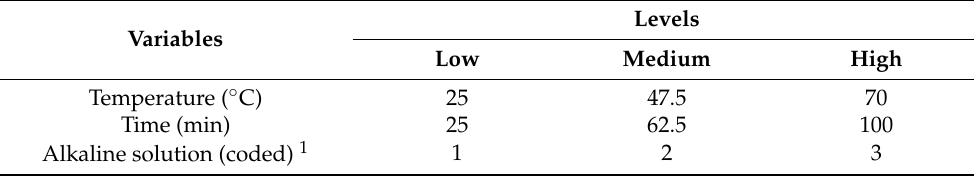
Table 1. Levels of the factors used in the Box–Behnken design. Levels Variables Low Medium High Temperature ( ◦ C) 25 47.5 70 Time (min) 25 62.5 100 Alkaline solution (coded) 1 1 2